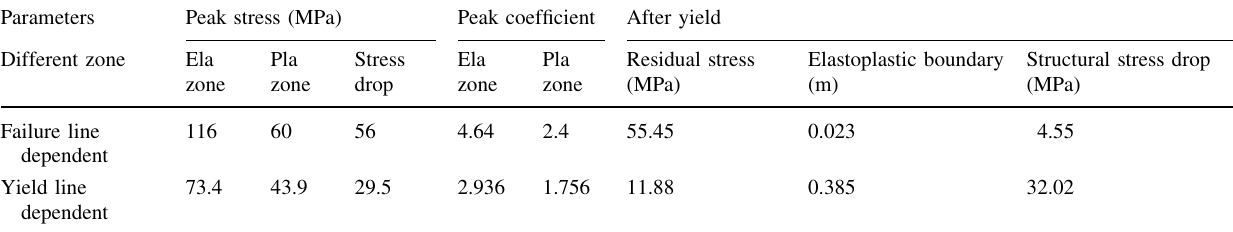
Table 2 Detailed results determined by yield or failure line Parameters